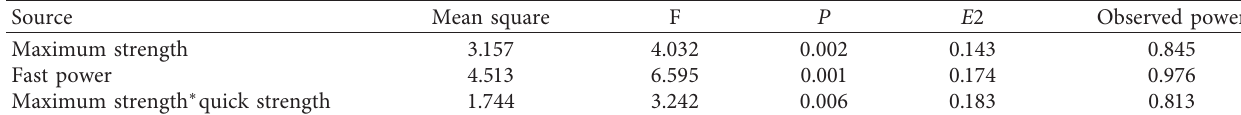
Figure 4: Sports visual importance scale for different sports. Table 1: Analysis of the interaction of tennis players’ strength